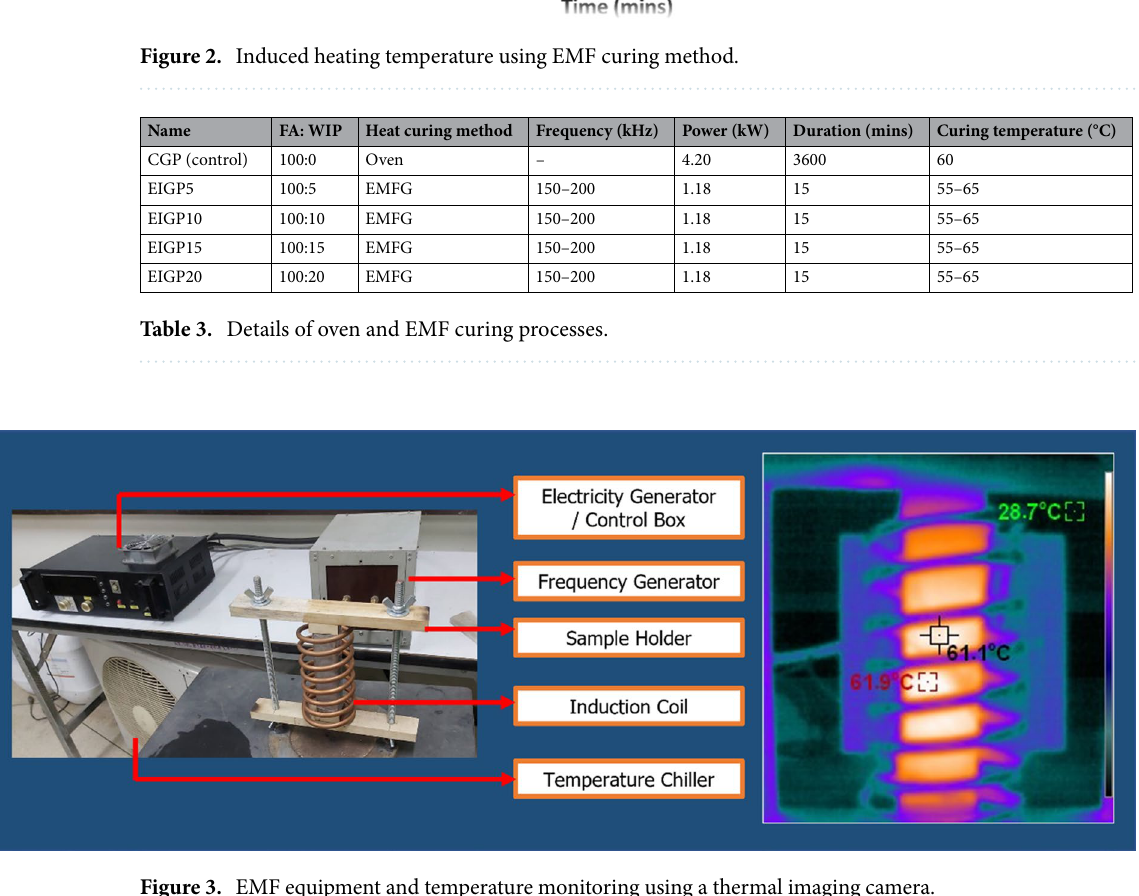
Figure 3. EMF equipment and temperature monitoring using a thermal imaging